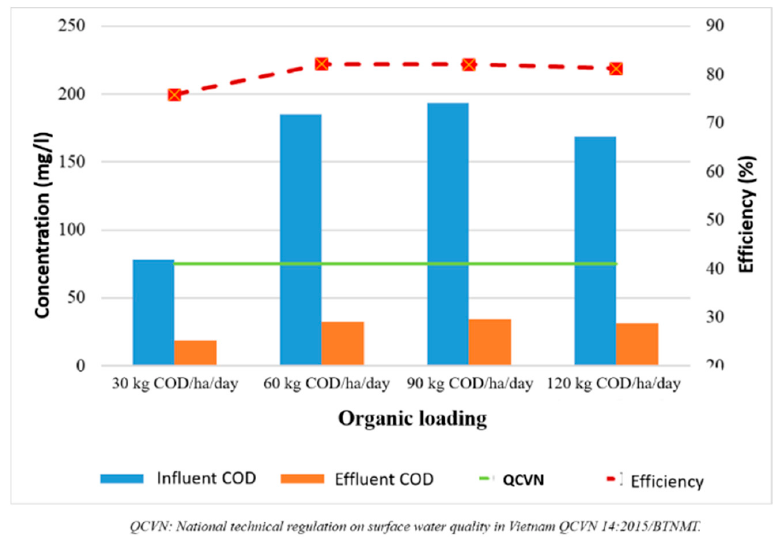
Figure 1. Effect of organic loading on COD removal efficiency.